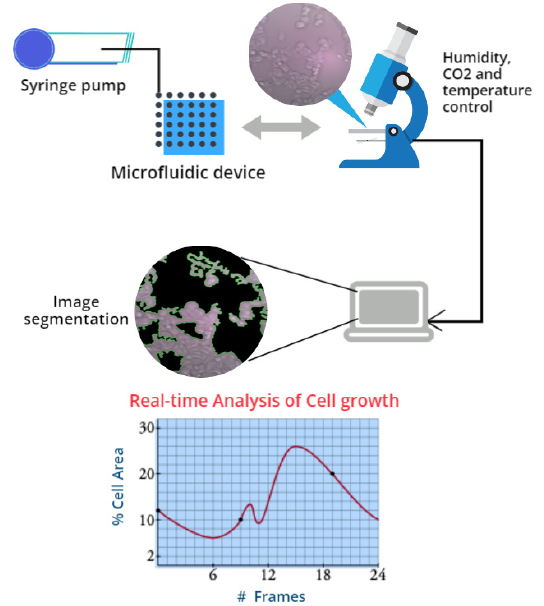
Figure 1. The computational system and hardware devices used in biological experiments.